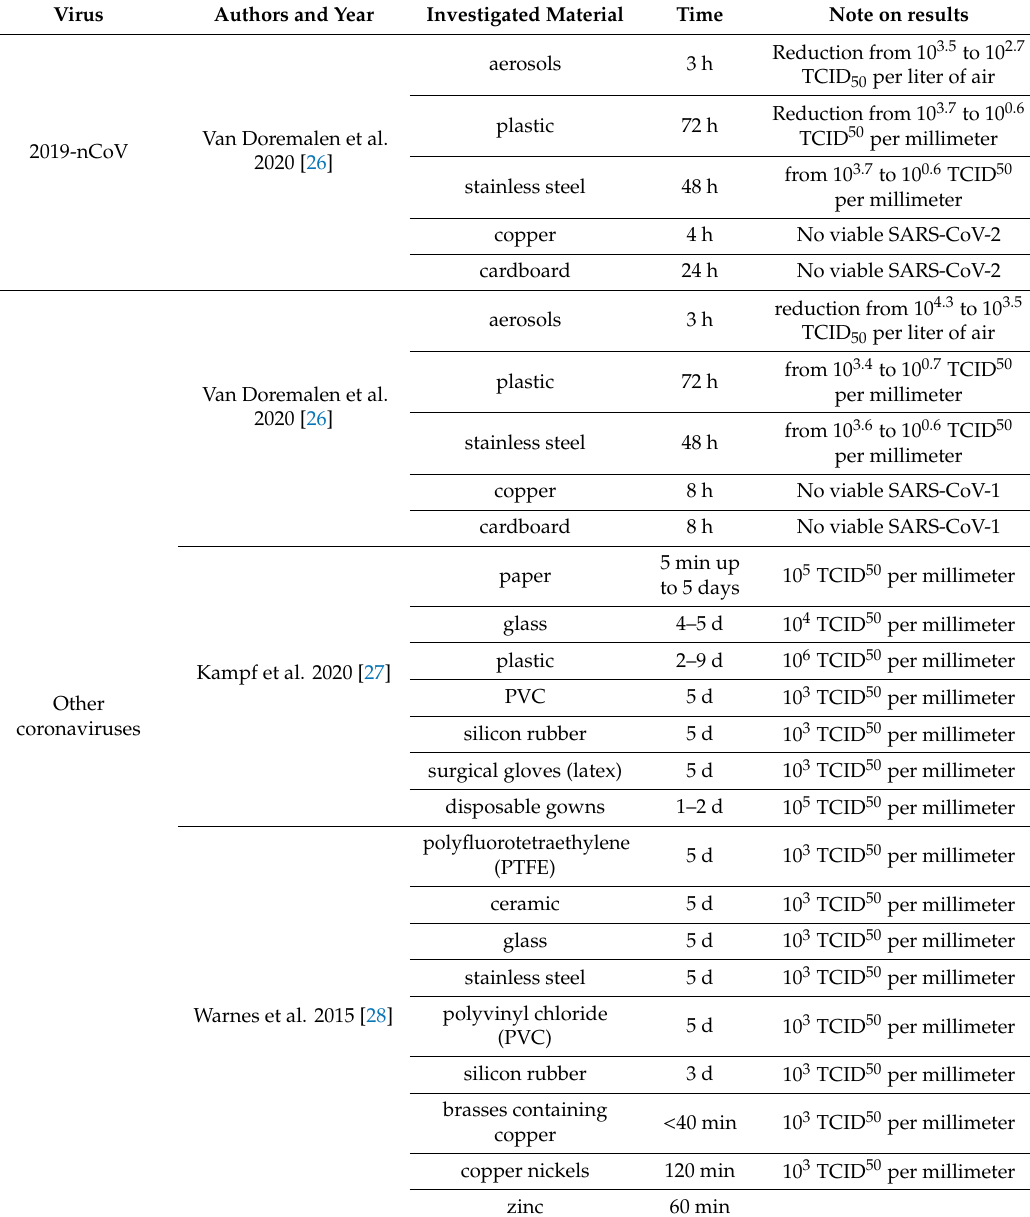
Table 1. Results of individual studies. Results are organized as described in Section